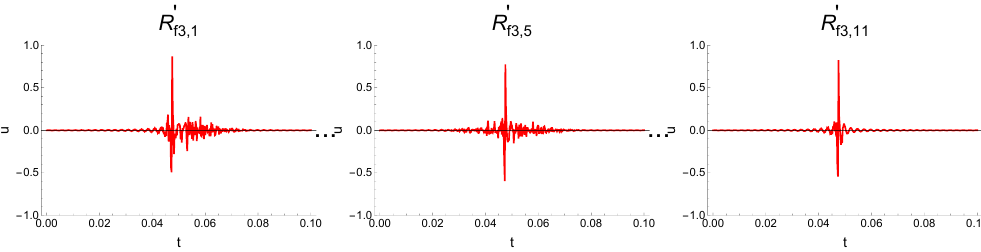
Figure 12. Three exemplary impulse responses R (cid:48) . Here, t is the time in seconds and u is the voltage f3, v to drive the loudspeaker. The shortest out of V = 11 impulse responses is ideal, as it exhibits the best impulse fidelity. It can be identified